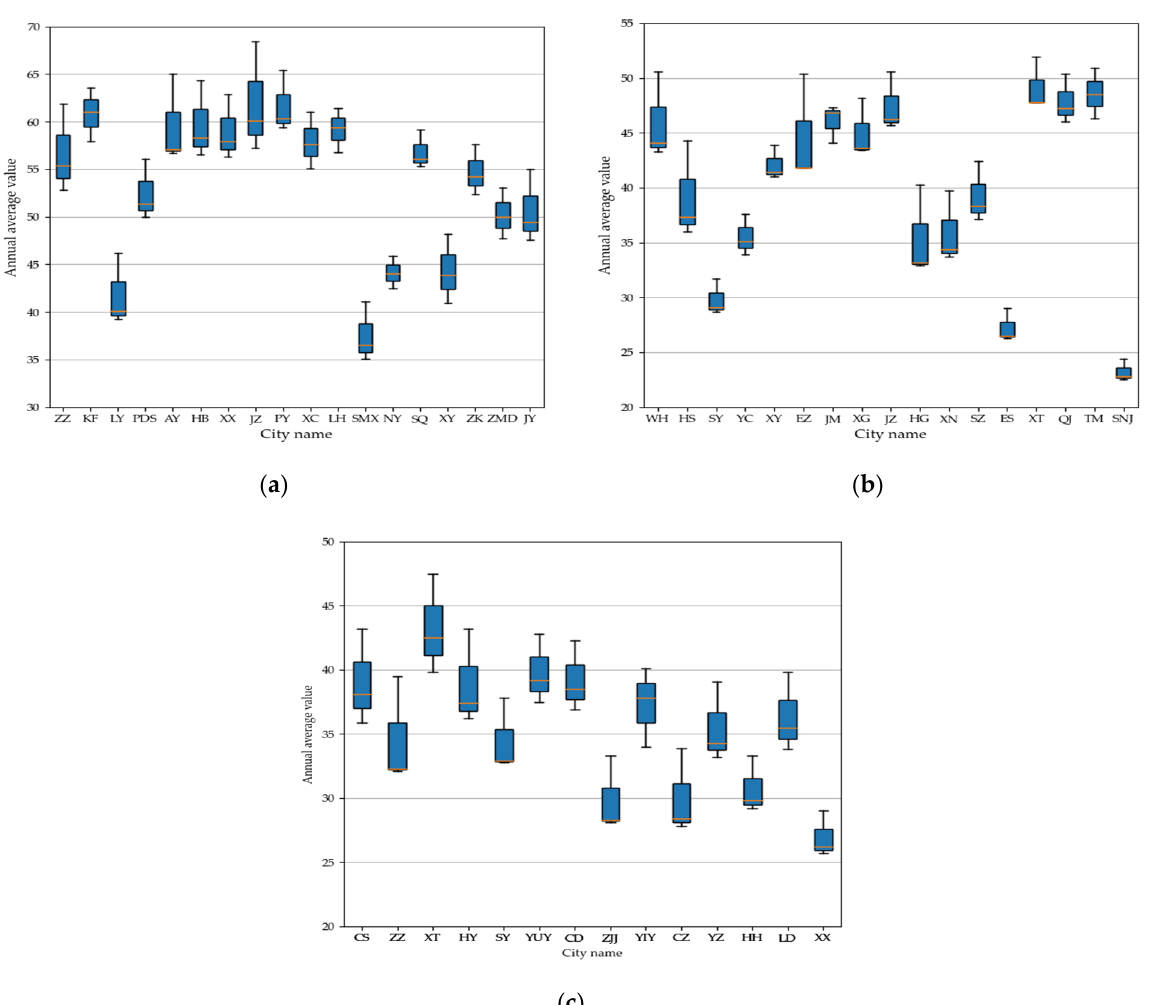
Figure 3. The changing trend of APIIU-AQI from 2017 to 2019: ( a ) Henan Province: Zhengzhou—